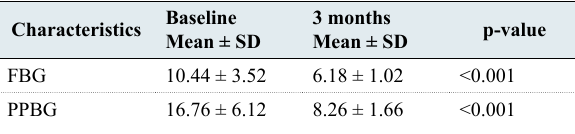
Table 2: Serum test results (fasting and post prandial blood glucose)